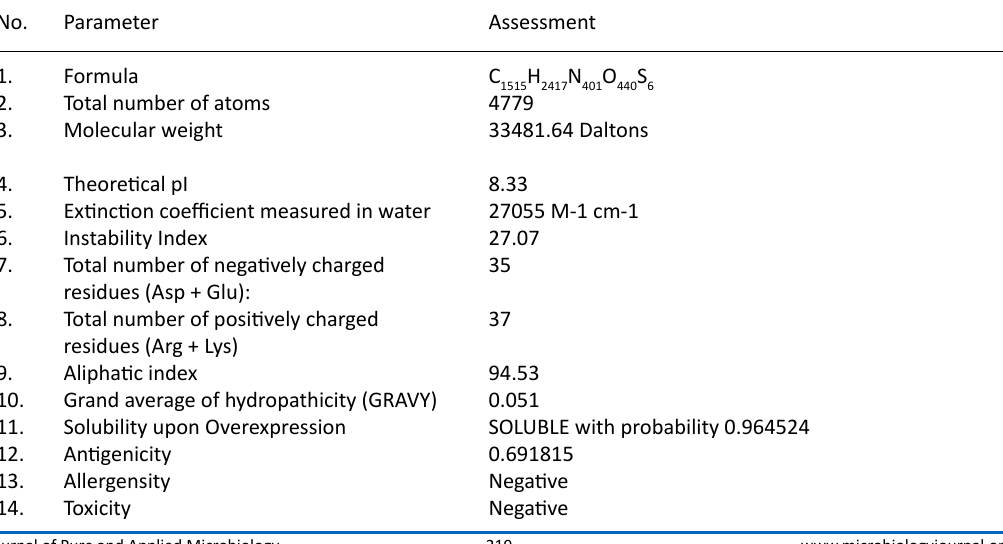
Table 3. Analysis of physiochemical, antigenic, allergenic and toxic properties